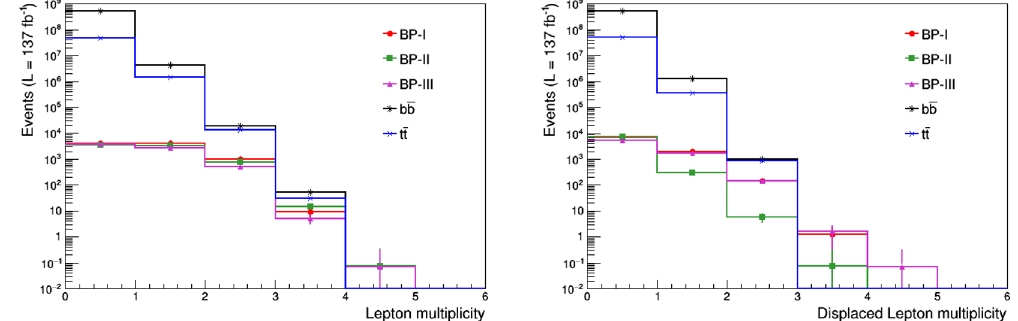
Figure 3 . Lepton multiplicity: all (left) and displaced (right).